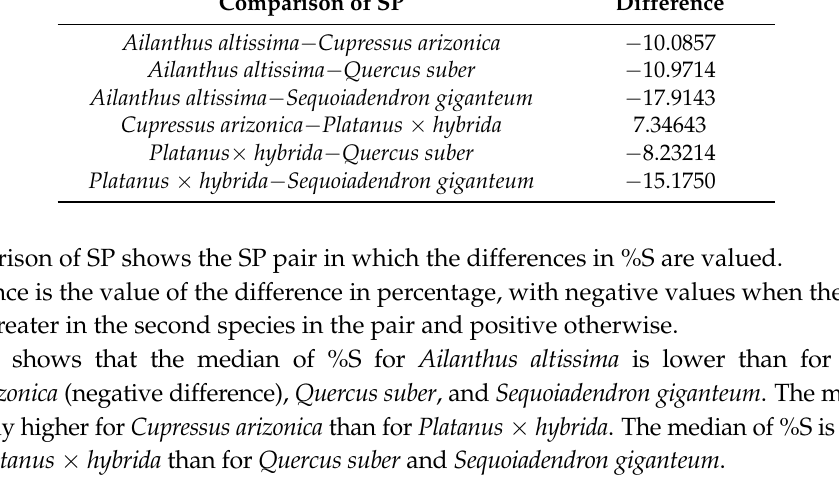
Table 9. Significant results to 95% of the multiple range test (LSD) for %0 according to SP.